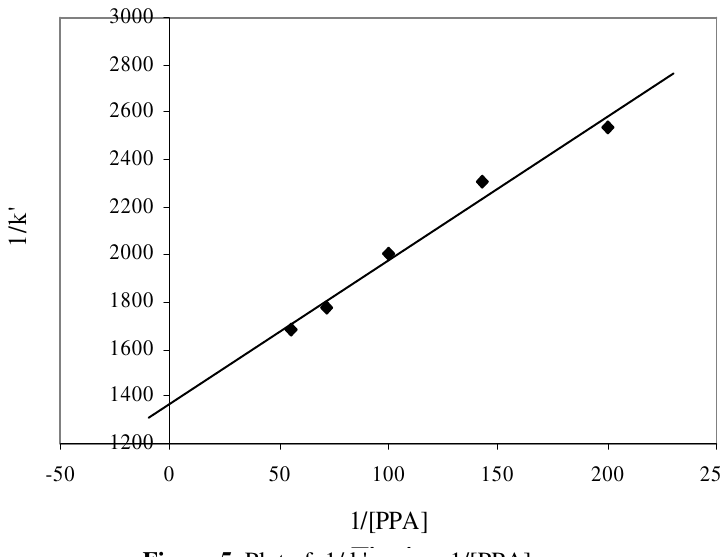
Fig.4 Figure 5 . Plot of 1/ k' versus